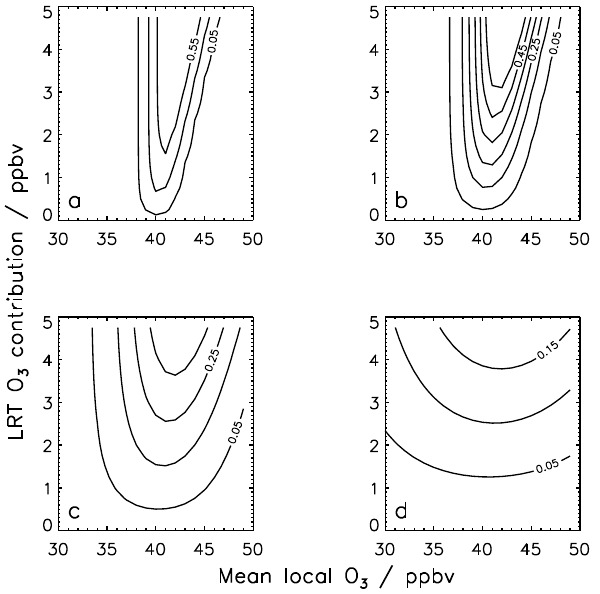
Fig. 14. Fractional change in AOT40 due to long-range transport (LRT) as a function of mean local ozone and LRT ozone contribu- tion. Panels (a–d) are based on normally-distributed local ozone distributions, with standard deviations of (a) 1ppbv, (b) 2 ppbv, (c) 4 ppbv and (d) 10 ppbv. The LRT contribution is assumed to uni- formly translate the local ozone distribution across all concentra- tions. AOT40 is assumed proportional to the fraction of distribution concentrations exceeding 40ppbv.